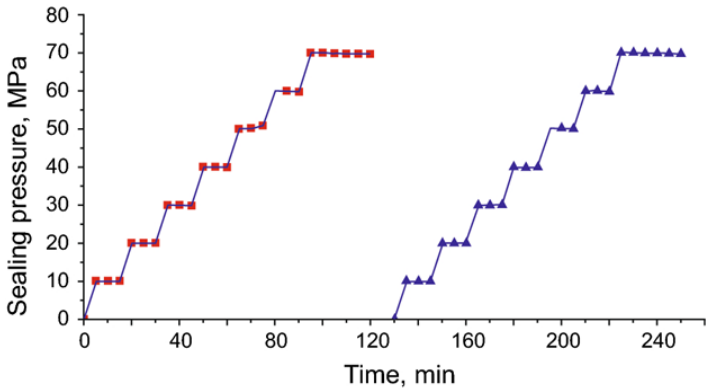
Figure 14. Sealing pressure maintained at the different time intervals of single barrel rubber with AFLAS element [83]. AFLAS element